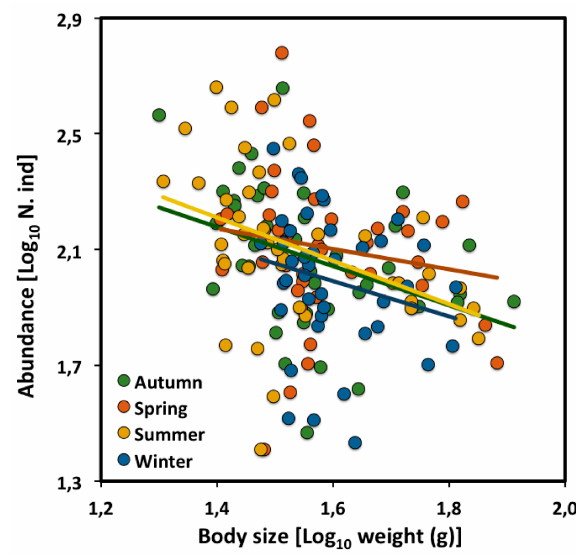
Figure A1. Scaling of density versus mean body size (live weight) of a desert rodent community in Portal Arizona through 41 years, from 1978 to 2018 (data from [34]) across the four seasons. Here, we show the LSR analyses of the rodent community CCSRs based on all of the years of the original data set. In this case, the only significant difference that was observed was a scaling exponent of − 0.35 for the spring samples, which was significantly lower than − 3/4 and that observed for samples taken during the other three seasons (Table A1, Figure A1). The scaling exponents for the autumn, summer and winter samples were not significantly different as well from the theoretical value of − 3/4. The elevations among the four seasons were not signi fi cantly di ff erent because of the high variation and the wide range of the 95% confidence interval of all four CCSRs (ANCOVA analysis comparing 95% confidence interval; Table A2). Table A1 . Results of LSR analyses of log10 population abundance (number of individuals) in relation to log10 body size (mg) of a desert rodent community in Portal Arizona (updated data from [34]). Table A2. p values for slope and intercept comparisons of the LSR analyses in Table A1. The di ff erences among slopes were assessed by comparing 95% CI. When the slopes were not significantly di ff erent, CCSR Slope the di ff erences between elevations were estimated by ANCOVA (with body mass as a covariate). p Value for Slope a p Value for Intercept b Seasons